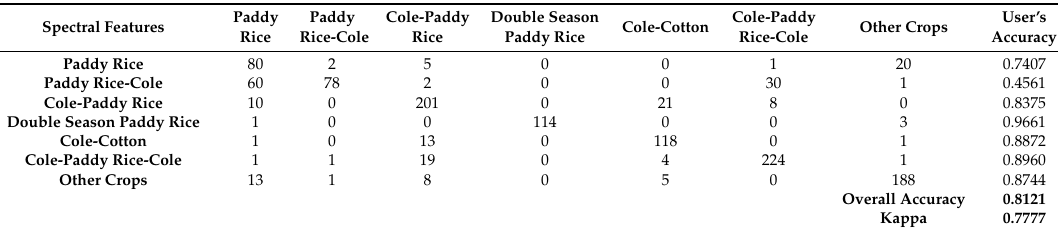
Figure 15. Overall accuracy comparison between classifications using different feature sets. SF means spectral features, PF means the proposed piecewise fitting method. Table 4. Confusion matrix of classification using spectral features.